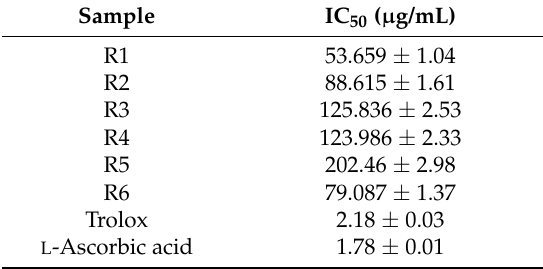
Figure 5. The DPPH free-radical scavenging capacity of six different parts of C. deserticola and the comparisons among sample R1 and reference antioxidants of Trolox and L -Ascorbic acid. Table 5. IC 50 value of different parts from cultivated C. deserticola in a DPPH radical scavenging assay ( n = 3).